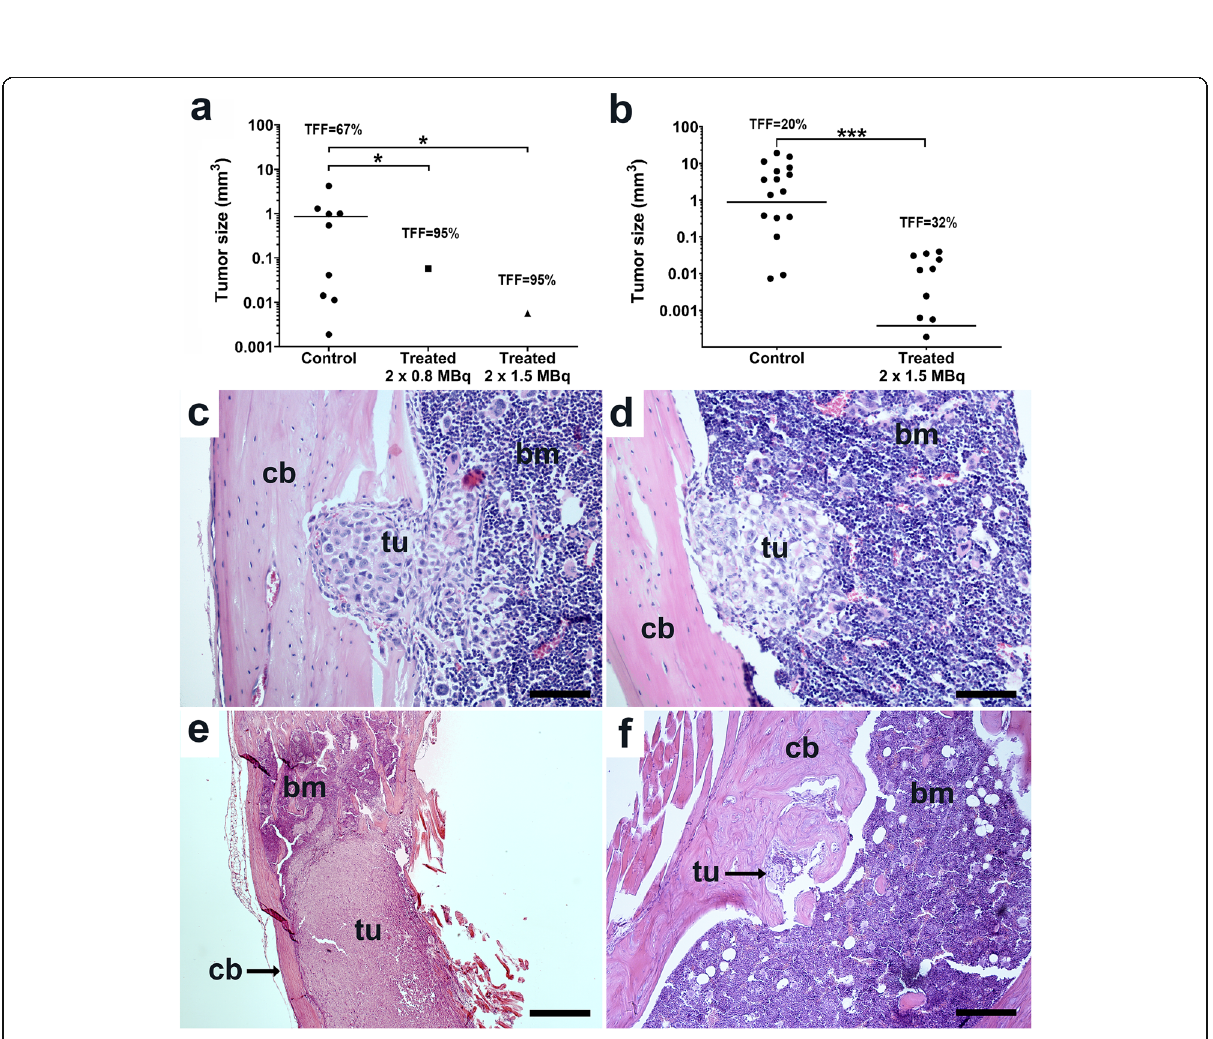
Fig. 5 Effect of alpha-RIT with 211 At-A11 on intratibial PC3-PSCA microtumors. Treatment was given twice two weeks apart. ( a ) Individual tumor sizes after treatment with 211 At-A11 in study 1. Lines represent the mean size of identified tumors. * p < 0.05 Mann-Whitney U test. ( b ) Individual tumor sizes after treatment with 211 At-A11 in study 2. *** p < 0.001 Mann-Whitney U test. Indicated is also the TFF for each group. ( c and d ) H&E staining of PC3- PSCA intratibial microtumors growing in the bone marrow and into the cortical bone at treatment start (7days after cell implantation). Untreated tumor at end of experiment ( e ), and treated tumor (2 × 0.8MBq) at end of experiment ( f ). Cortical bone (cb), bone marrow (bm), tumor (tu). Magnification 200×, black scale bar: 100 μ m ( c and d ), magnification 40×, scale bar: 500 μ m ( e and f ) TFF tumor free